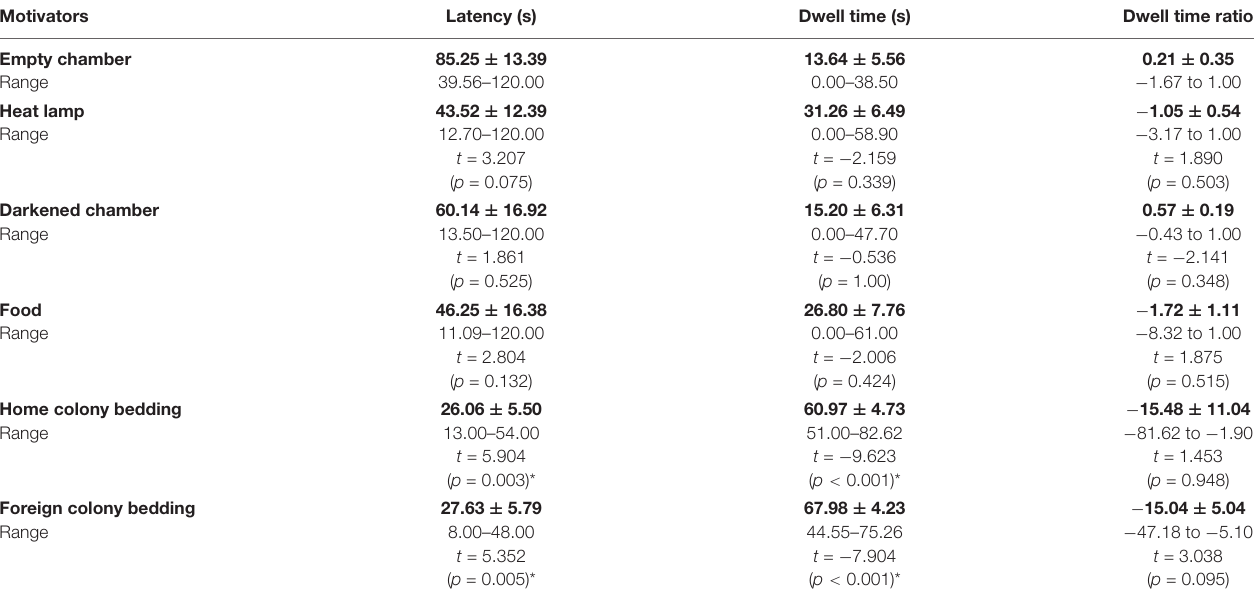
TABLE 2 | Assessment of reward chamber